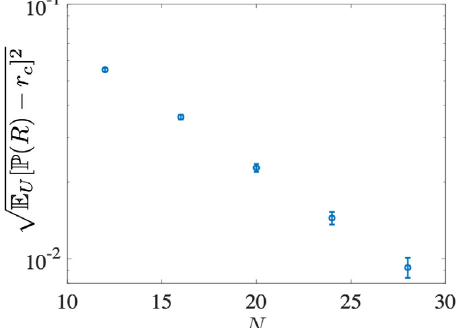
FIG. 11. Fluctuations in the recovery probability over random codes vs N for the fixed-fraction erasure model with R ¼ 1 = 2 at e ¼ e . The recovery probability for a random code appears to be c self-averaging towards the RMT prediction r a depth 2 N encoding circuit in 1D with a brickwork arrangement of gates. Each two-site gate in the circuit is a random Clifford